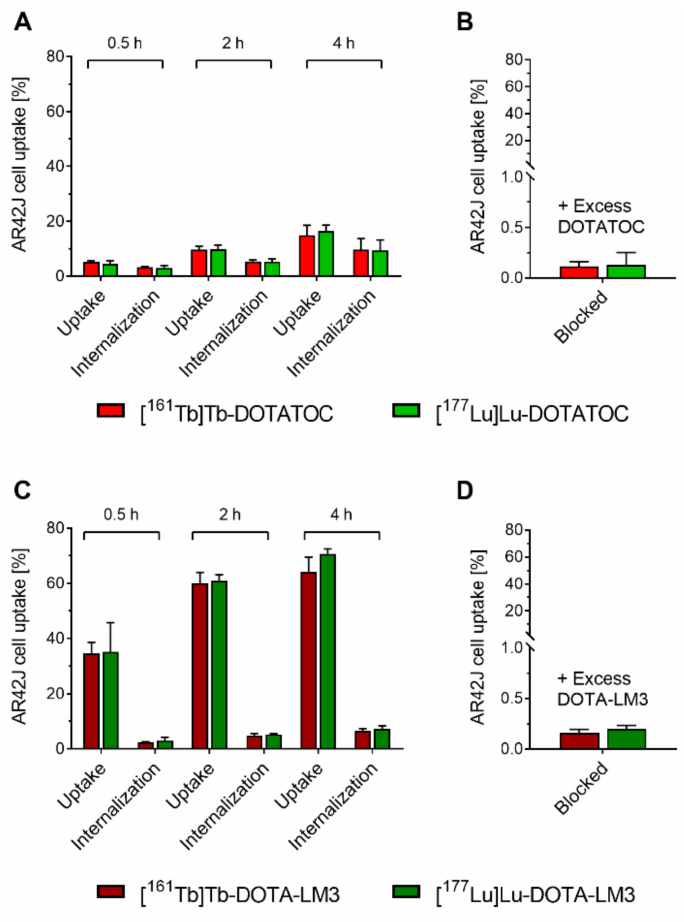
Figure 1. Results of the in vitro uptake and internalization of the radiopeptides in AR42J tumor cells after incubation for 0.5 h, 2 h and 4 h. ( A ) [ 161 Tb]Tb-DOTATOC and [ 177 Lu]Lu-DOTATOC; ( B ) [ 161 Tb]Tb-DOTATOC and [ 177 Lu]Lu-DOTATOC with excess DOTATOC; ( C ) [ 161 Tb]Tb-DOTA- LM3 and [ 177 Lu]Lu-DOTA-LM3; ( D ) [ 161 Tb]Tb-DOTA-LM3 and [ 177 Lu]Lu-DOTA-LM3 with ex- cess